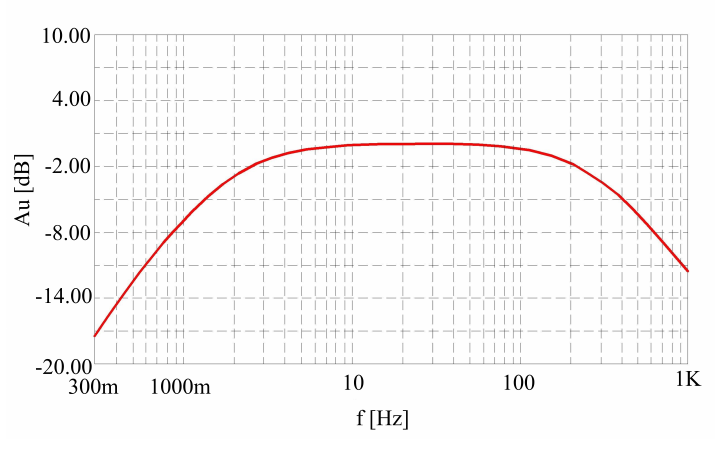
Figure 6. Frequency range of the ViGeo2